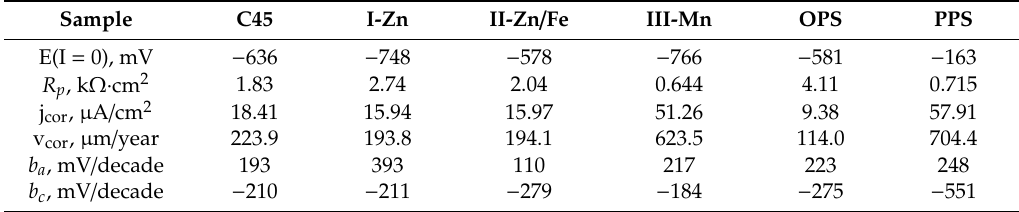
Table 3. Parameters of the instantaneous corrosion process for the samples studied in Black Sea